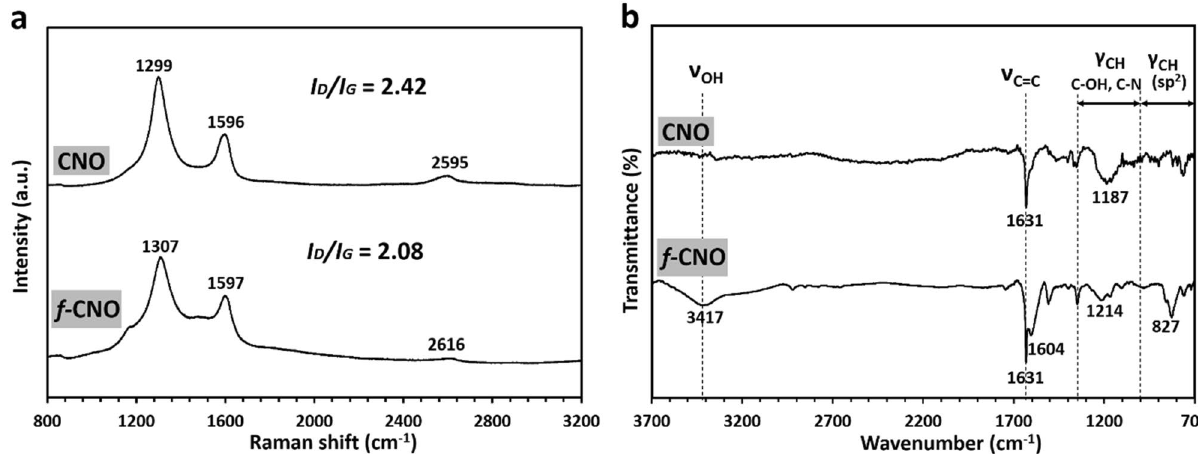
Figure 1. ( a ) Raman and ( b ) FTIR spectra of CNO and f